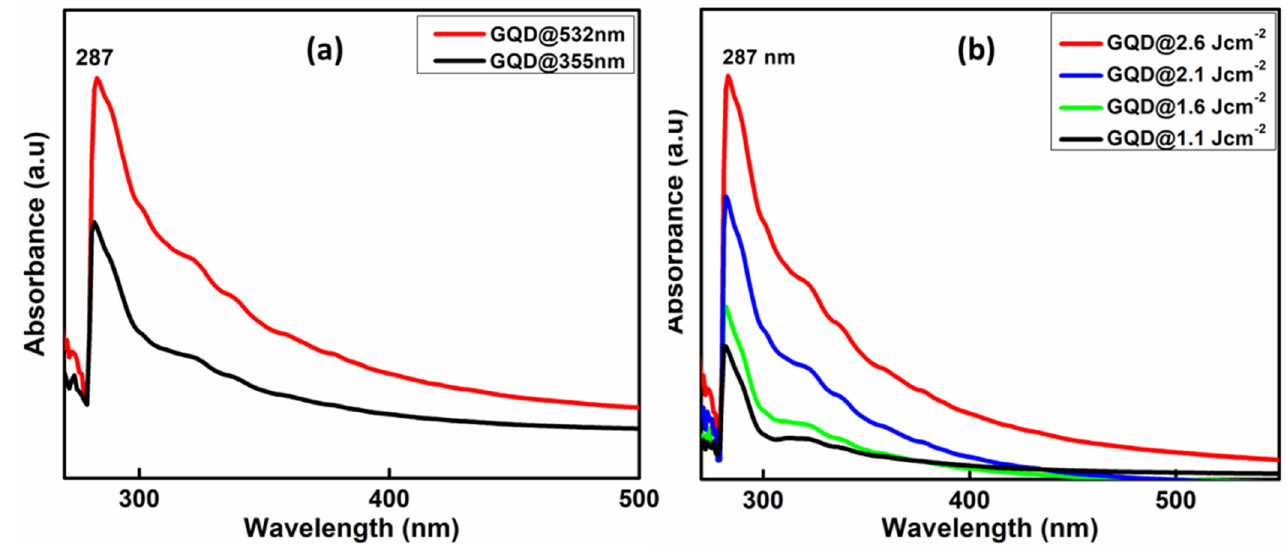
Figure 4. ( a ) UV ₋ Visible absorption spectra of GQDs synthesized at different laser wavelengths and ( b ) at different laser fluences.